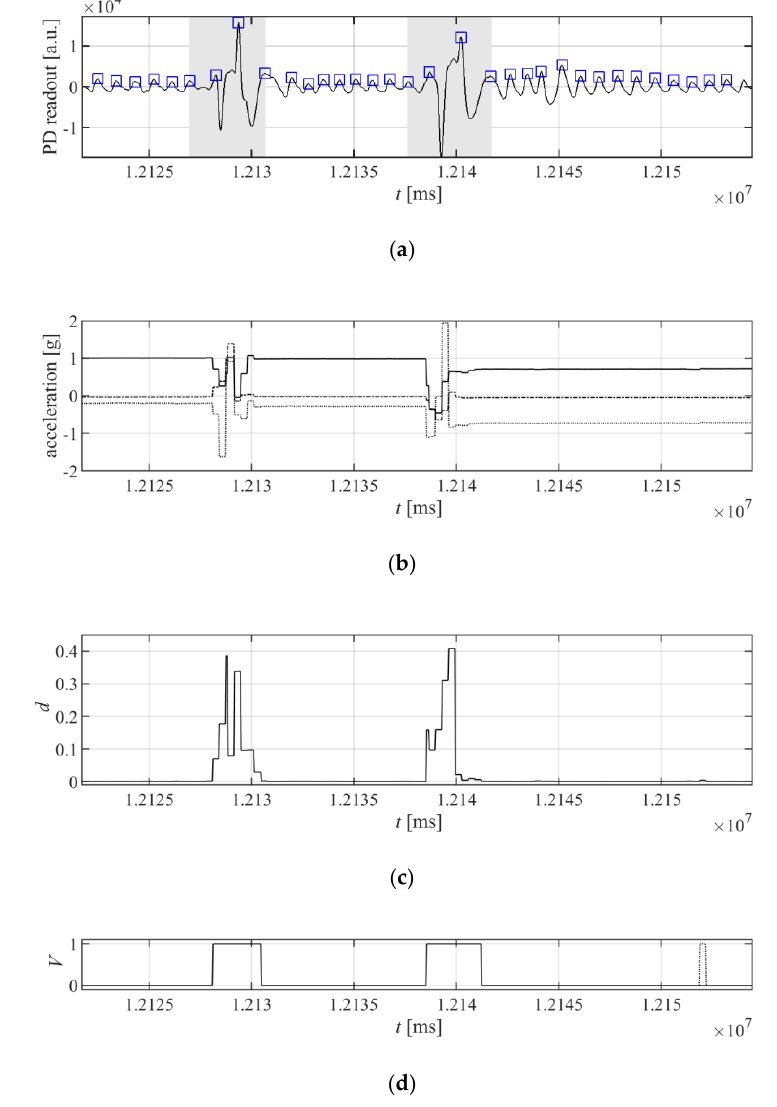
Figure 7. Elimination of the patient’s movement from pulse-signal detection: ( a ) the PPG signal distorted with the patient’s movement; the areas in gray are excluded from pulse period calculation due to the detected movement; ( b ) acceleration values read from the accelerometer placed together with the heart rate detector on the wrist, ( c ) and the values of movement d i from Equation (11); ( d ) signal d i after threshold, as in Equation (12), and with the eliminated short-term peaks (the eliminated peak is shown with a dotted line).